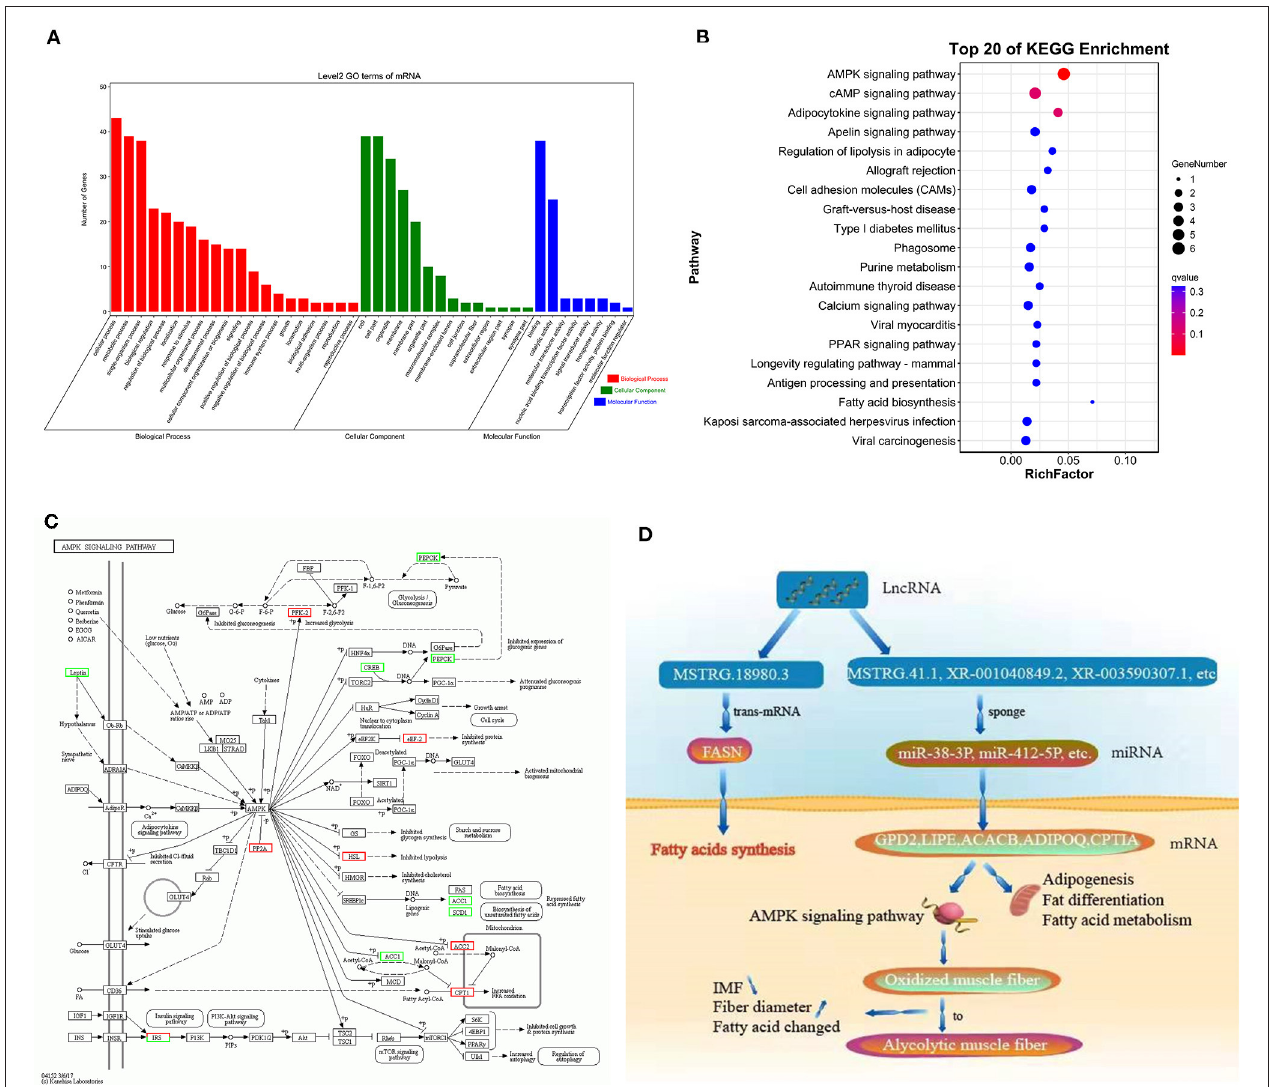
FIGURE 7 | (A) Histogram of mRNA GO function annotated in ceRNA network. (B) Bubble chart of Kyoto encyclopedia of genes and genomes (KEGG) enrichment analysis. (C) AMPK signaling pathway during the growth and development of Tibetan sheep. (D) Model of lncRNA regulating lipid metabolism in Tibetan sheep.